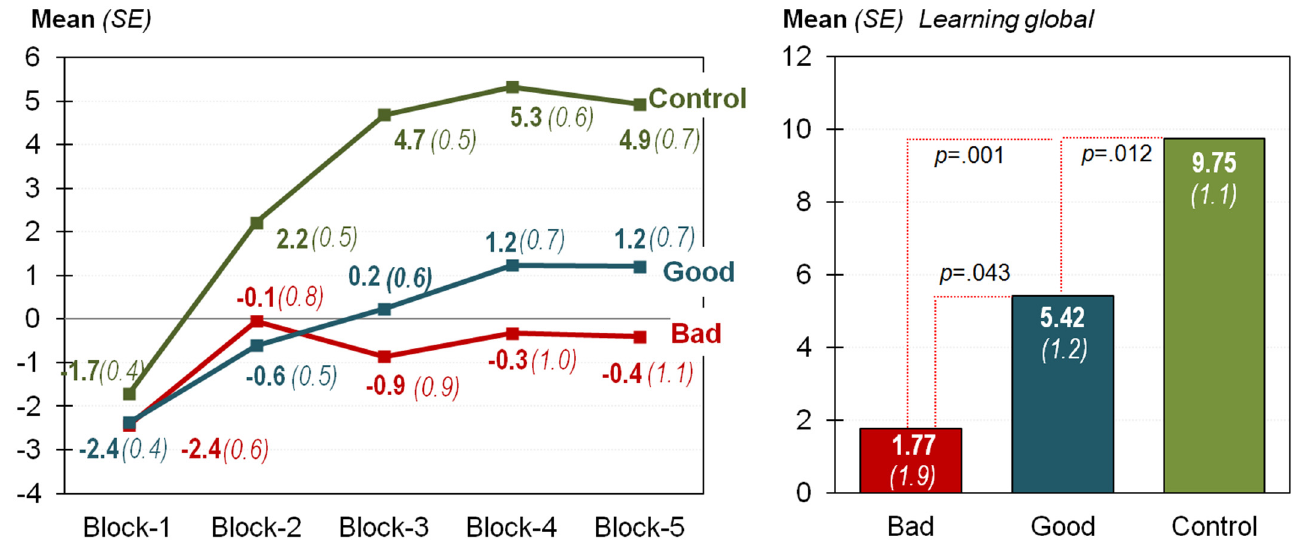
Figure 1. Iowa Gambling Task (IGT) performance–learning curves ( left ) and IGT global scores by group ( right ). Note. Sample size n = 424. SE: standard error.